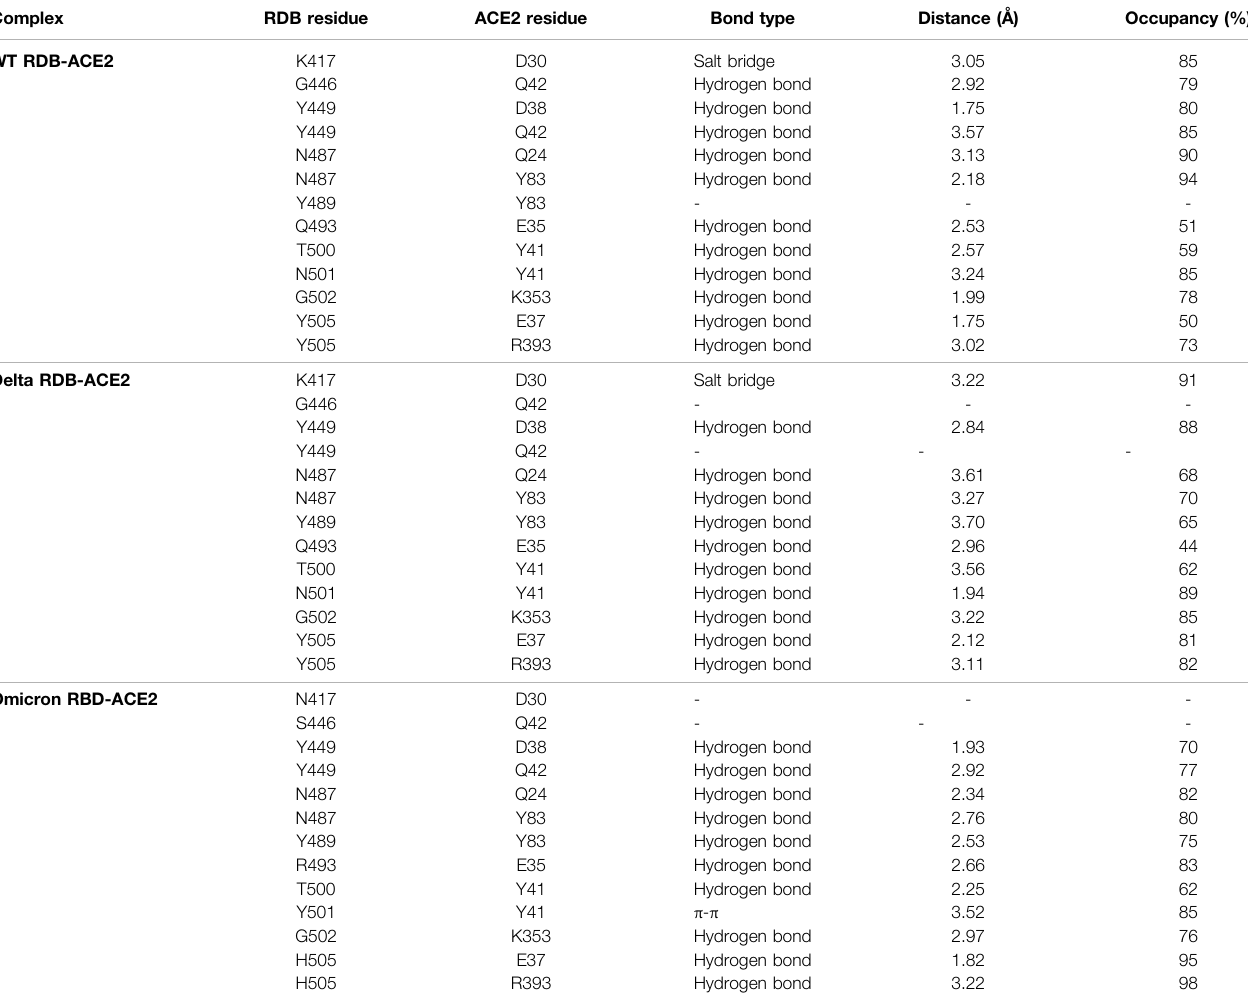
TABLE 1 | Comprehensive detail of intermolecular interaction of interfacial residues of RDB of WT, Delta, and Omicron with human ACE2 receptor.